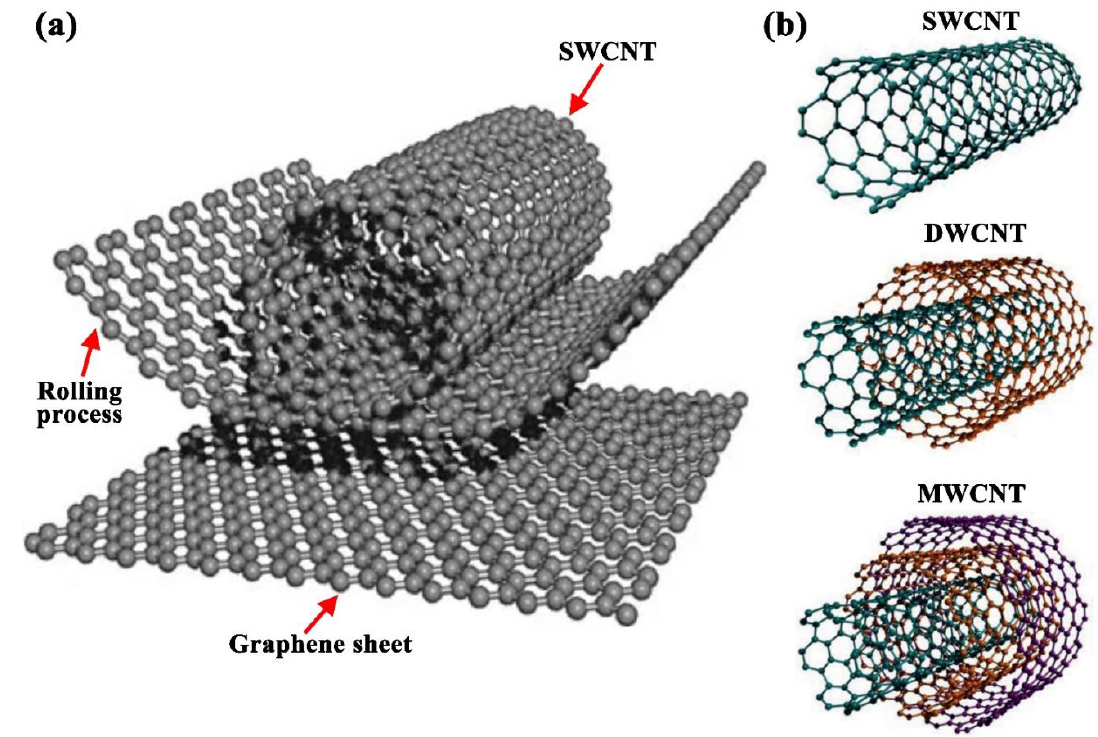
Figure 7. Carbon nanotubes formation and classifications, where ( a ) illustrates the rolling mechanism of graphene sheet into SWCNT and ( b ) demonstrates the three different categories of CNTs, namely SWCNT, DWCNT, and MWCNT.